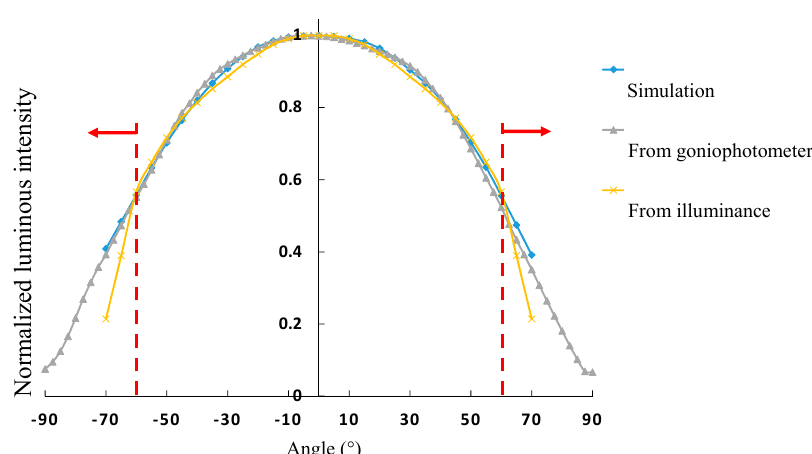
Figure 8. Luminous intensity distributions derived from goniophotometer measurement, illuminance measurement, and simulation.